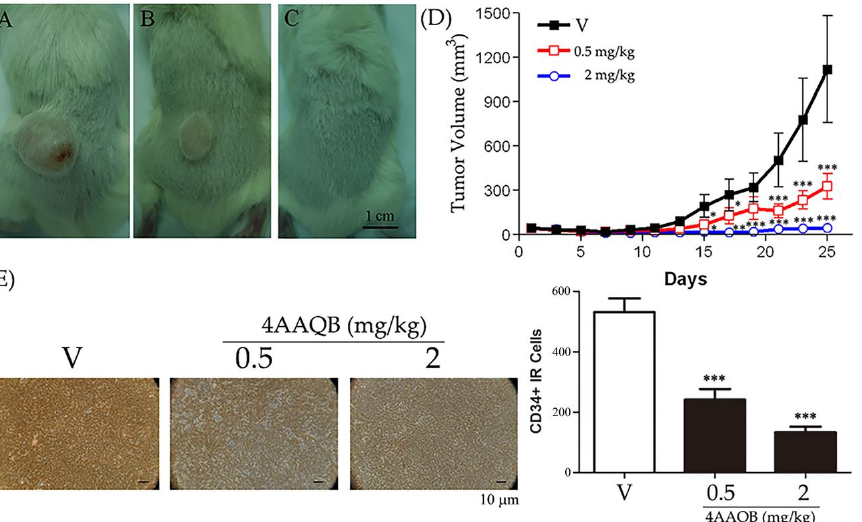
Figure 3. Anticancer effects of 4AAQB in in vivo models: SCID mice administered with the vehicle or indicated dosage of 4AAQB are displayed in ( A – C ) (vehicle (V), 0.5 mg/kg, and 2 mg/kg, re- spectively); the tumor volumes of the xenograft models are shown in ( D ); data are represented as means ± SEM ( n = 8); ( E ) expression of CD34 in the cancer xenograft was revealed by staining, and the CD34-immunoreactive (IR) cells were counted. Data are represented as means ± SEM ( n = 6). Scale bar = 1 cm ( A – C ) or 10 µ m ( E ). * p < 0.05, ** p < 0.01, and *** p < 0.001 compared to the vehicle